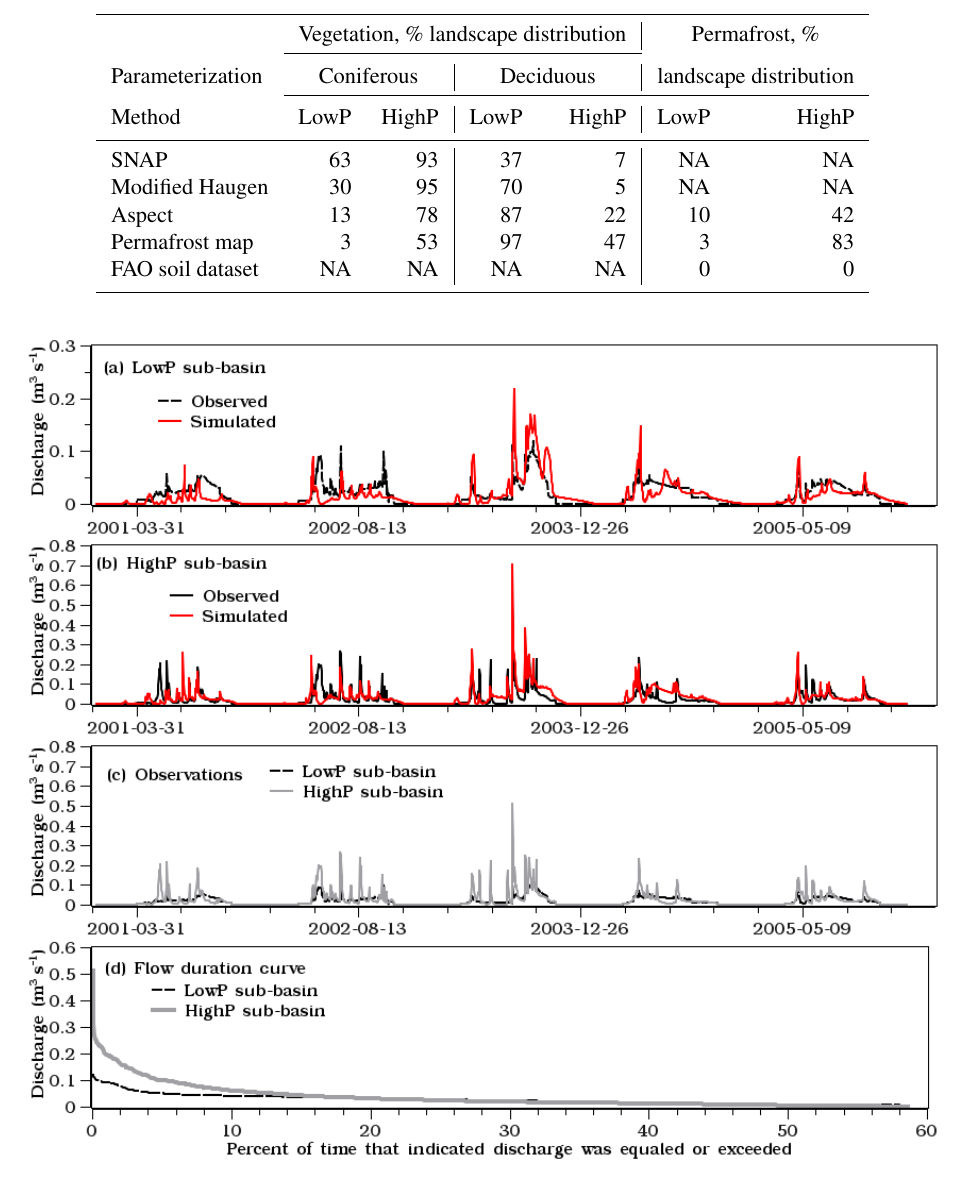
Figure 5. Observed versus simulated streamflow during the calibration period of 2001–2005: (a) at the LowP sub-basin and (b) at the HighP sub-basin of the CPCRW. The discharge contrasts between HighP and LowP sub-basins are shown in panels (c) and (d) . Panel (c) denotes the streamflow hydrograph and (d) denotes the flow duration curve in both